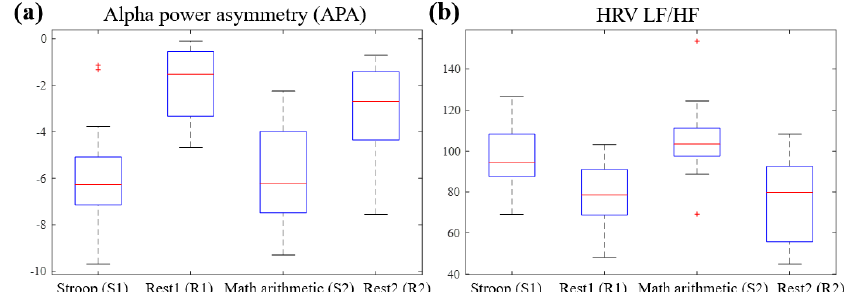
Figure 11. Box blots of features with significant differences between the stress and rest periods. ( a ) Alpha power asymmetry. ( b ) Heart rate variability (HRV) low-frequency power/high-frequency power (LF / HF). The boxes represent the 25th and 75th percentiles, the lines within the boxes represent the means, and the lines outside the boxes represent the most extreme data points not considered outliers. The plus symbol indicates